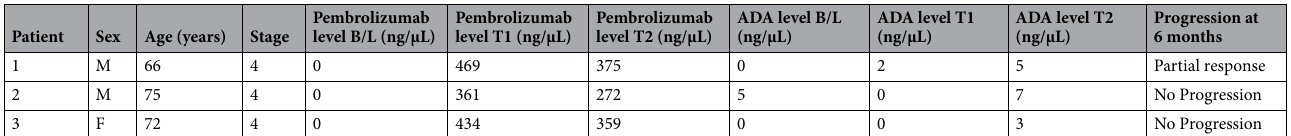
Table 2. Characteristics of patients with falling pembrolizumab drug level and rising anti-drug antibody level.